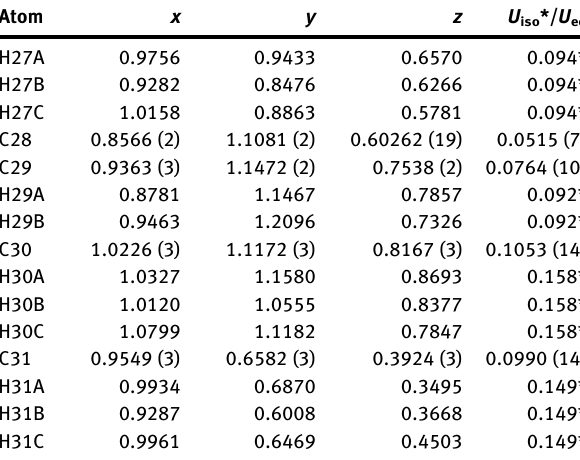
particular, fl uorescein hydrazones with pyrrole- and